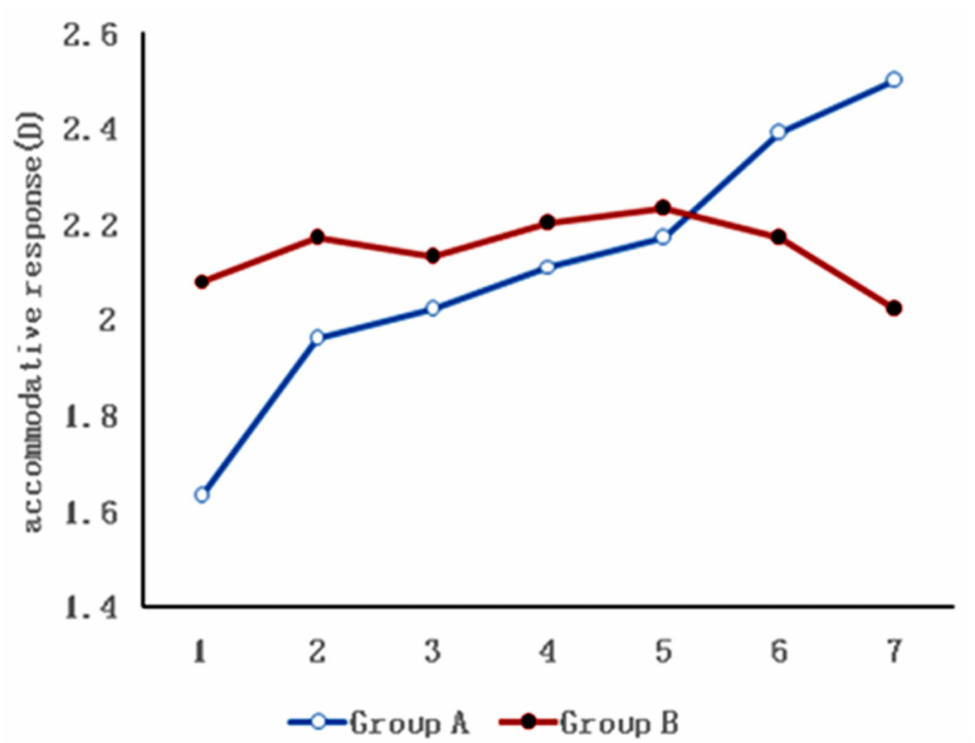
Figure 3. Effects of dynamic lighting (Group A) and static lighting (Group B) on accommodative response. The abscissa from 1 to 7 comprises 5, 100, 200, 500, 1000, 2000 and 3000 lux illuminances for Group A. The abscissa from 1 to 7 comprises 7 sessions of 1000 lux illuminances for Group B.